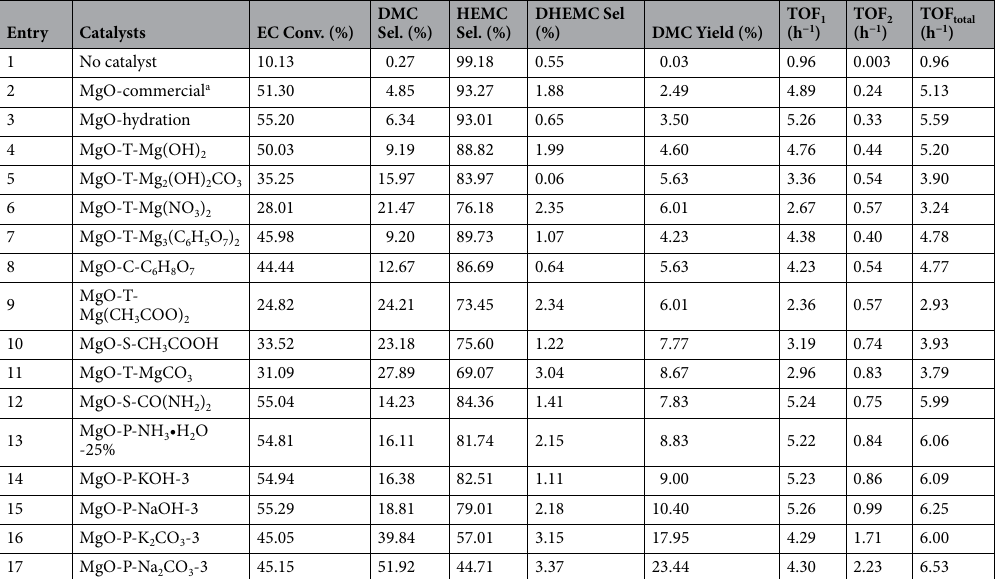
Table 1. The effect of different MgO preparation methods on transesterification efficiency. Reaction condition: molar ratio of EC/MeOH = 1/6, catalyst amount = 3 wt%, reaction temperature = 68 °C, reaction time = 0.5 h. a The commercial MgO was calcined at 500 °C for 3 h before